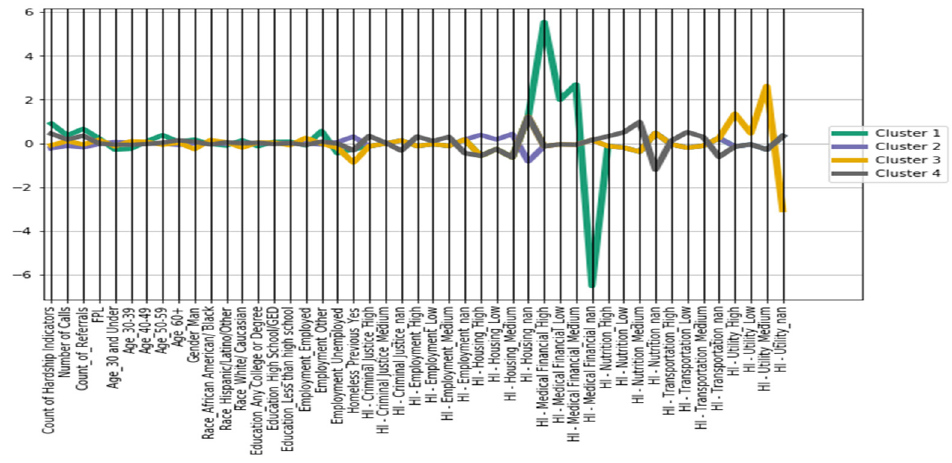
Figure 1. Cluster analysis results.